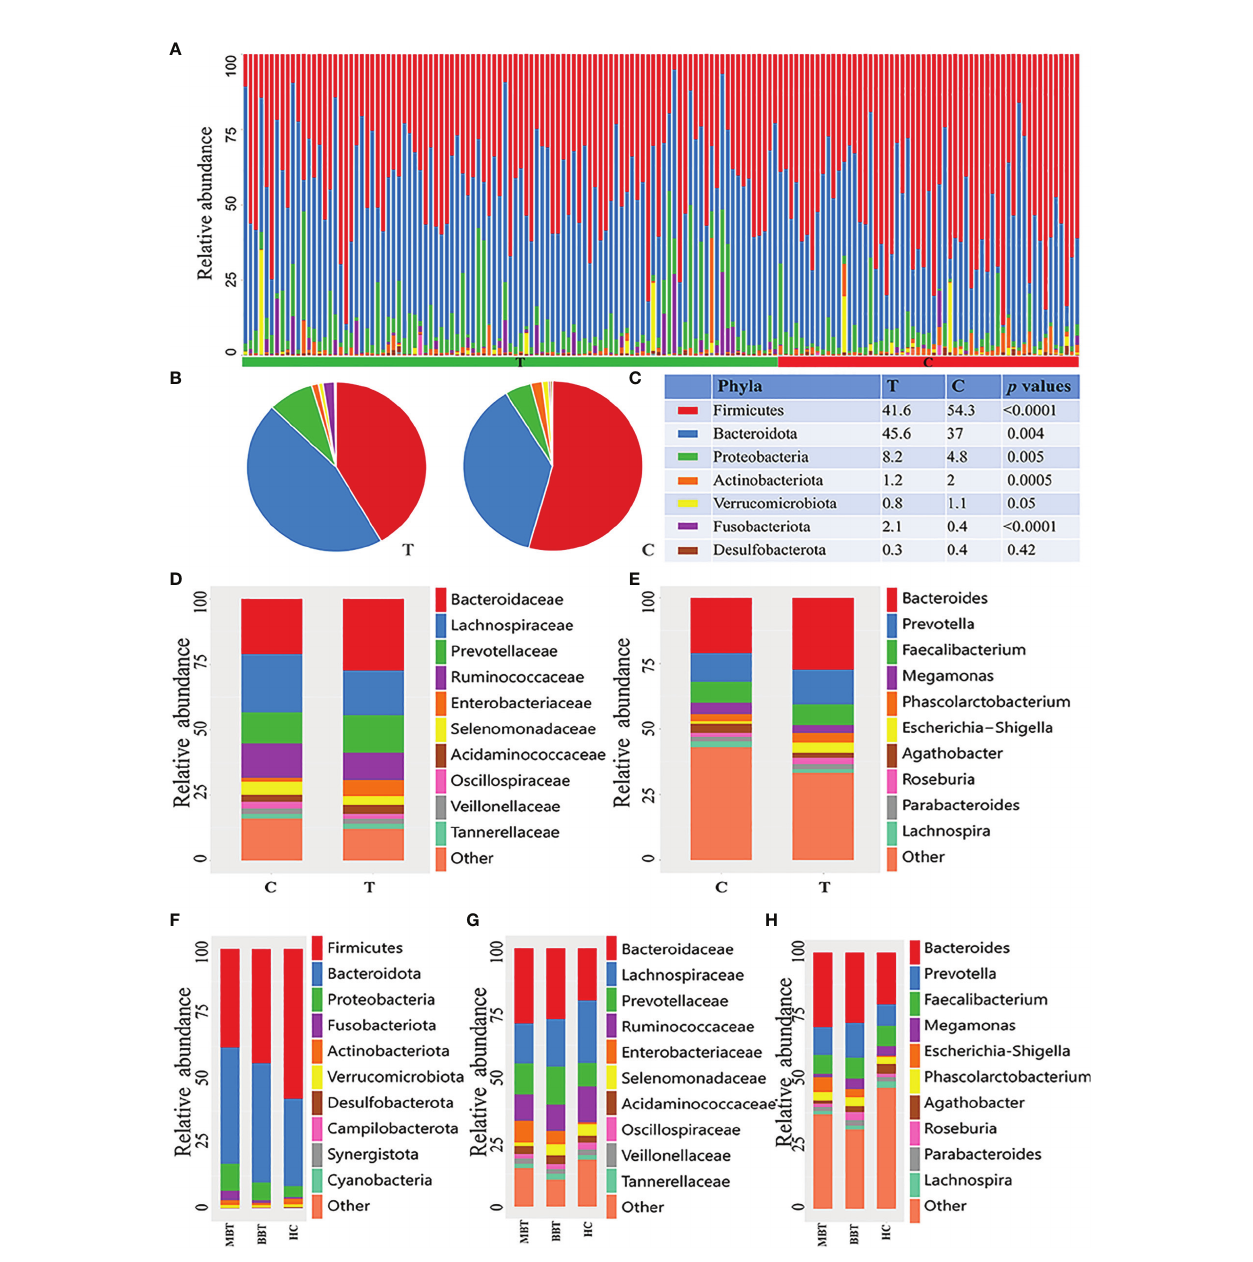
FIGURE 2 | Composition of microbial community at different levels of different groups. The phylum-level distribution of all samples (A), brain tumor group and healthy group (B) . The proportion and comparation of the top seven bacteria at phylum level of T and C groups (C) . Each color represents a kind of bacteria. The microbial family (D) and genera (E) between T and C groups. And the analysis of subgroups at the level of phylum (F) , family (G) and genus (H) in malignant brain tumours (MBT), benign brain tumours (BBT) and healthy group